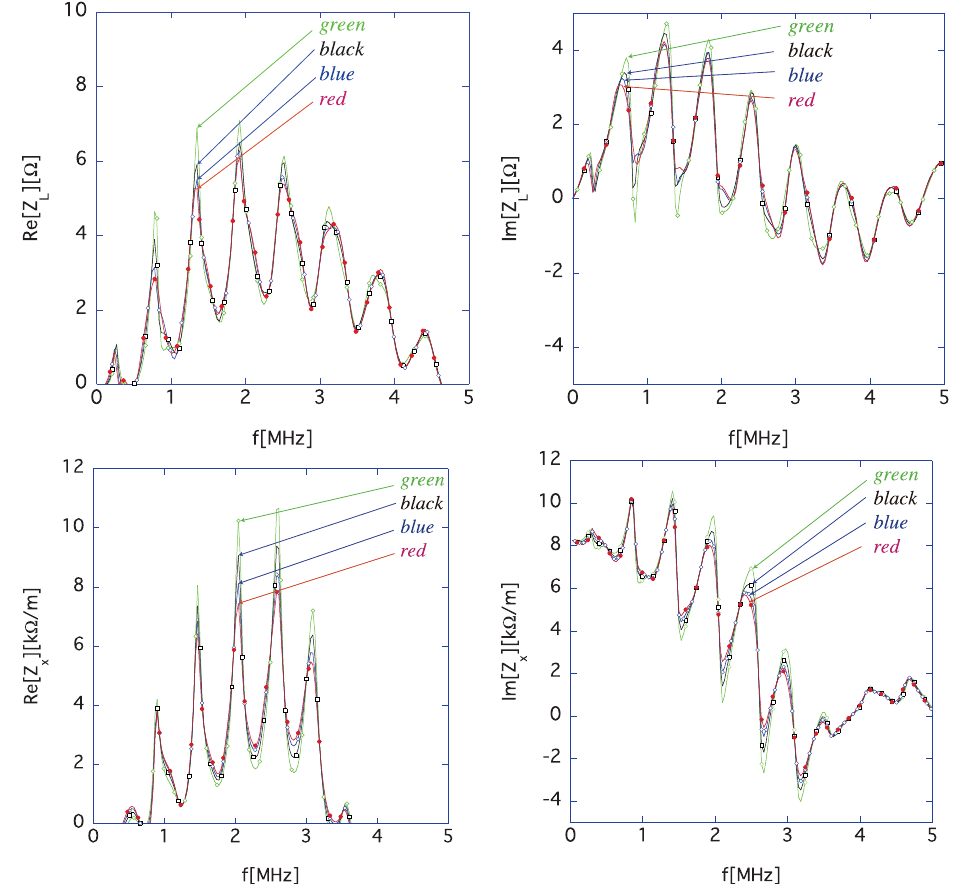
FIG. 12. Simulation results for the longitudinal (upper row) and horizontal (lower row) beam impedances, where the diodes and resistors are installed. The wire radius is ρ w ¼ 80 μ m and the twin-wire separation is Δ ¼ 60 mm. The green open circle, black square, blue diamond, and red filled circle lines show the results for 1 . 245 × 10 13 (300 kW-eq), 2 . 075 × 10 13 (500 kW-eq), 3 . 11 × 10 13 (750 kW-eq), and 4 . 15 × 10 13 (1 MW-eq) particles per bunch, respectively. The left and the right columns show the real and the imaginary parts of the beam impedances,